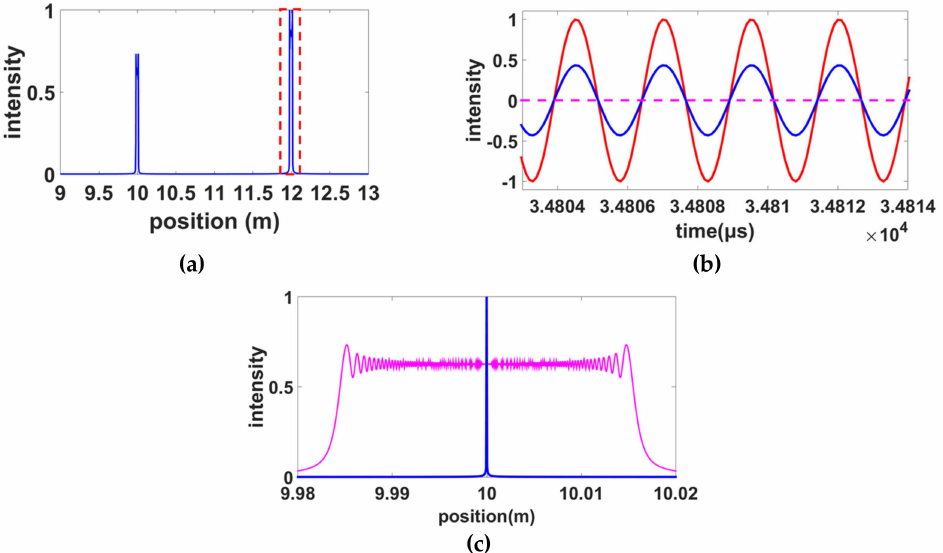
Figure 7. ( a ) Two reflection peaks in the spatial domain broadened by the nonlinearity tuning of the laser. ( b ) The interference patterns over a period of time. The blue curve is the ideal interference pattern in the temporal domain. The red curve is the signal recovered by the band-pass filtered signal shown in (a). ( c ) The pink and blue curves are the first reflection peak without and with the nonlinearity correction using the self-reference method. All intensities are